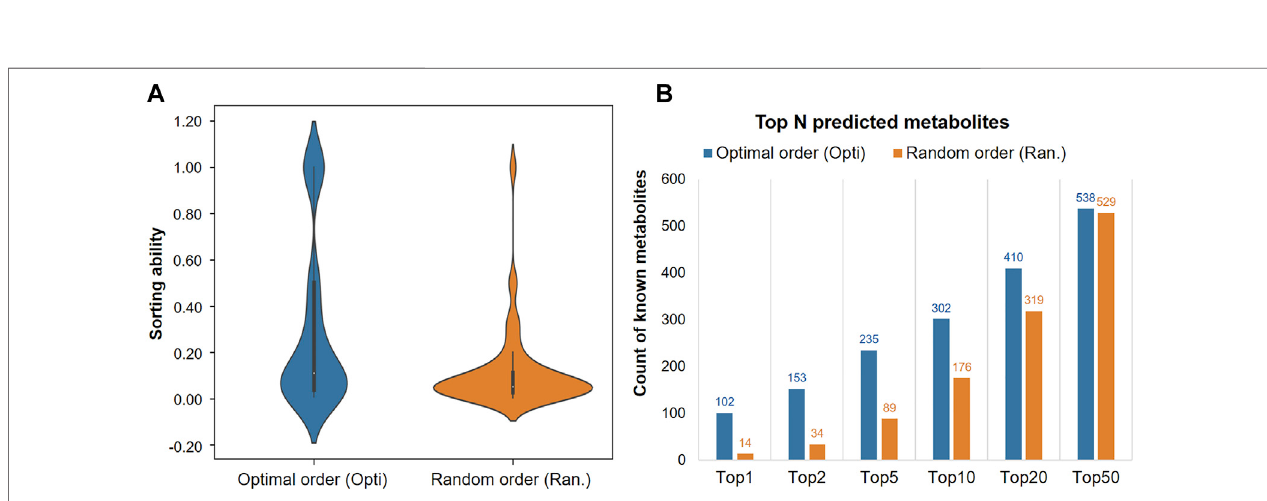
FIGURE 4 | Prioritizing ability of MetNC on different orders of functional groups. (A) Ranking position distribution of known metabolites on different orders of functional groups ( n = 850). (B) Number of known metabolites in the Top-N prediction list on different orders of functional groups.